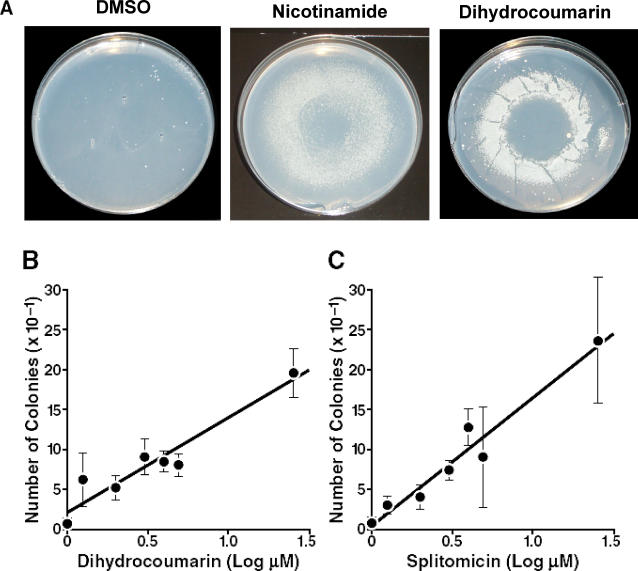
Effect of DHC on Heterochromatin Silencing in S. cerevisiae at the HMR or HML Loci(A) DMSO negative control, 1 M nicotinamide positive control, and 50 mM DHC.(B and C) DHC and splitomicin, respectively, cause dose-dependent increases in heterochromatin silencing and colony formation.